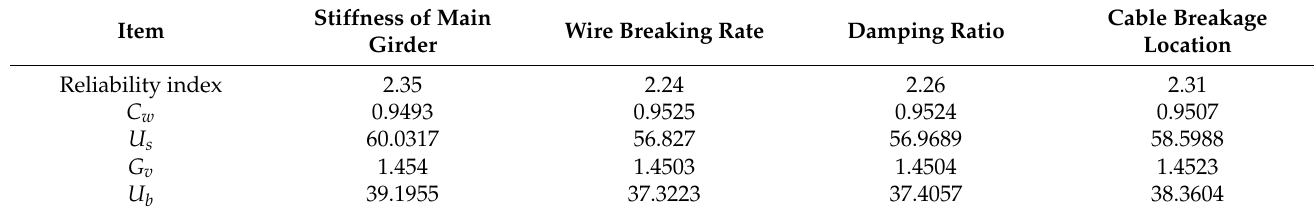
Table 10. Calculation results of flutter reliability.